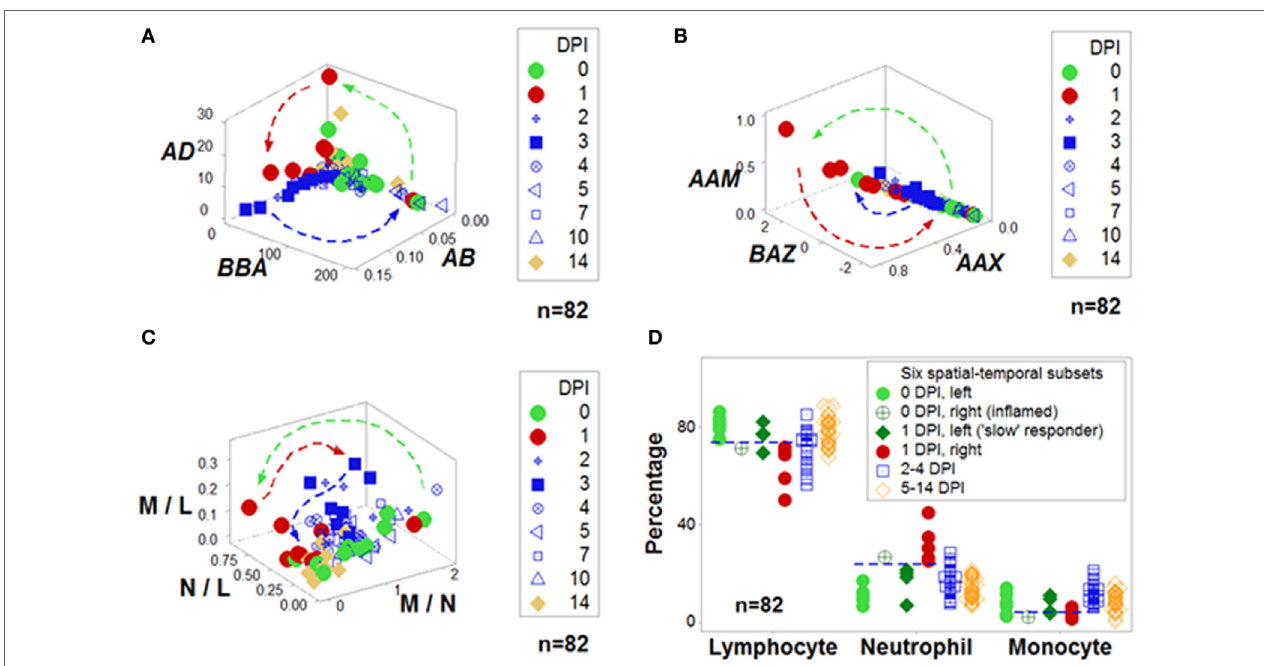
FiGURe 2 | integration of non-reductionism and reductionism . To both validate and interpret the non-reductionist graphic patterns (described in Figure 1 ), additional non-reductionist data analyses and reductionist (cell type-based) operations may be required. Highly complex data structures can demonstrate both discrimination and robustness (A,B) . In contrast, data structures of lower complexity may fail to distinguish changes that occur within 2 weeks (C) . Based on spatial–temporal patterns, numerous data subsets may be identified and interpreted. For instance, in this example, before challenge [0 day(s) postinoculation (DPI)], all birds but one were located on the left side of the plots displayed in Figure 1 [light green circles (D) ]. In contrast, 24 h later (at 1 DPI), most challenged birds were on the right side [red symbols (D) ]. However, some birds appeared to be “slow” responders: even at 1 DPI, they exhibited the profile of 0 DPI birds [dark green diamonds (D) ]. The opposite profile was displayed by one 0 DPI animal, which revealed high neutrophil and low lymphocyte percentages [e.g., a profile indicative of an inflammation not due to the experimental challenge, dark, green circle with inserted cross (D) ]. Inferences are facilitated by arrows that denote temporal data directionality (A–C) as well as non-overlapping data distributions [indicated by the horizontal lines (D) ]. Because most data combinations have identical contents— except the three “words” [L and M, N and M, and L and N, shown in (C) ], any other combination includes all data points of all three cell types (A,B) , information does not depend on data inputs (identical for all but three indicators) but relationships, e.g., three-dimensional/four-dimensional (spatial–temporal) data “shapes”, which can be rapidly validated and analyzed—as shown in the Movie S1 in Supplementary Material. Data source: Ref.